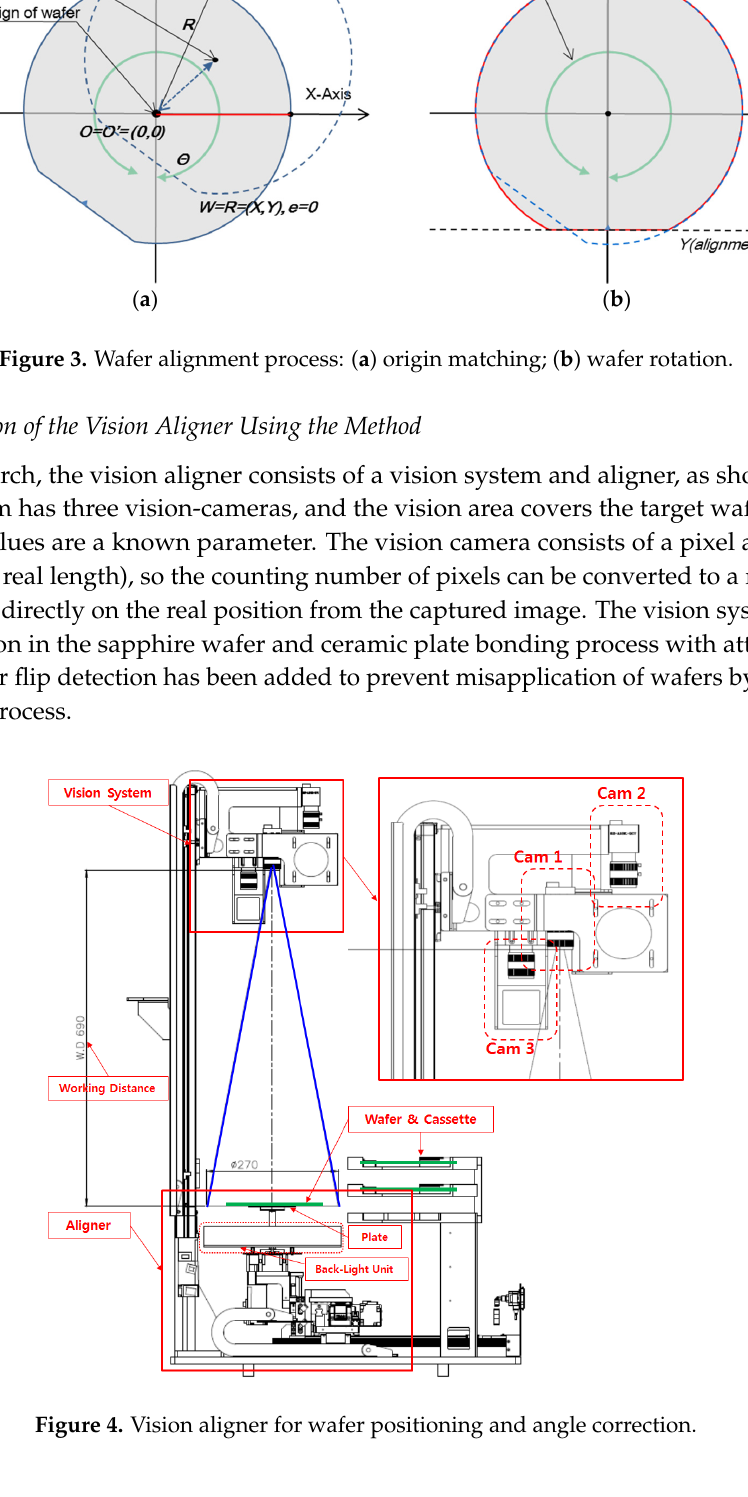
Figure 4. Vision aligner for wafer positioning and angle correction.